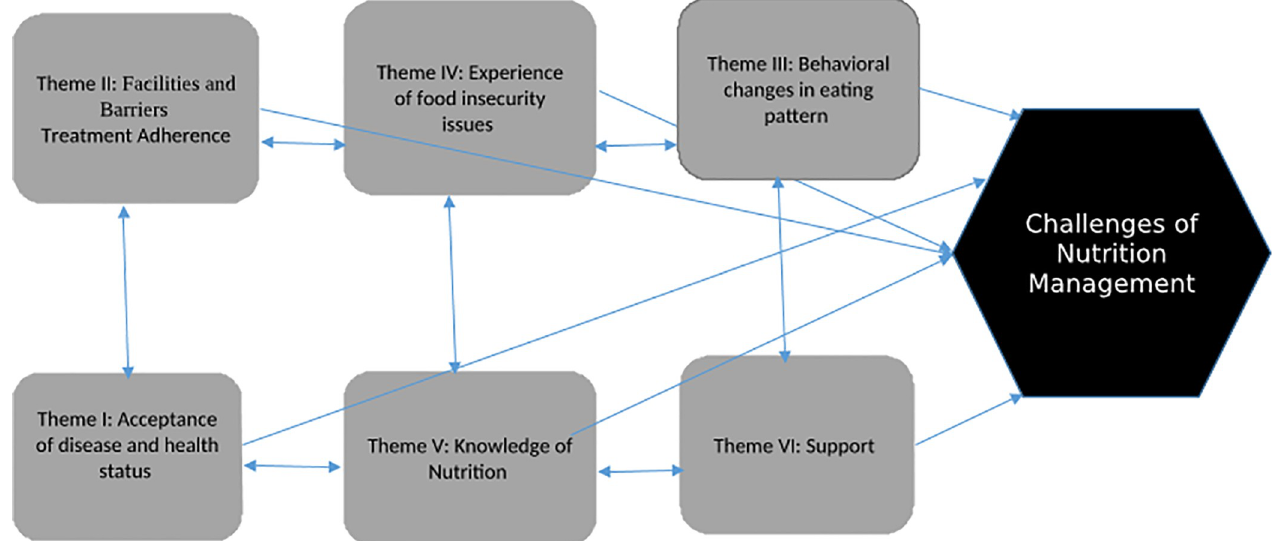
Fig 1. Thematic map of identified themes: Interaction between themes and burden to manage nutrition among HIV patients on ART.